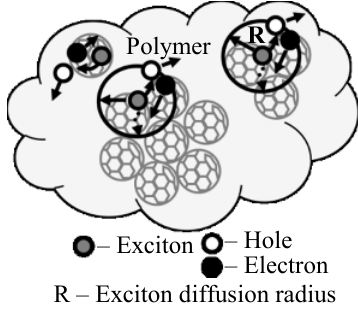
Fig. 3. Schematic representation of photoinduced processes after fullerene